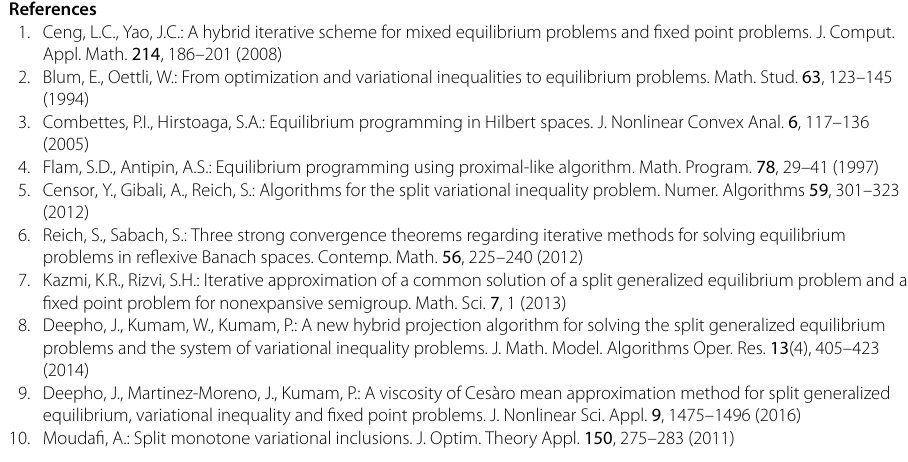
for solving a class of split generalized equilibrium problems and fixed point problems for a countable family of nonexpansive multivalued mappings in real Hilbert